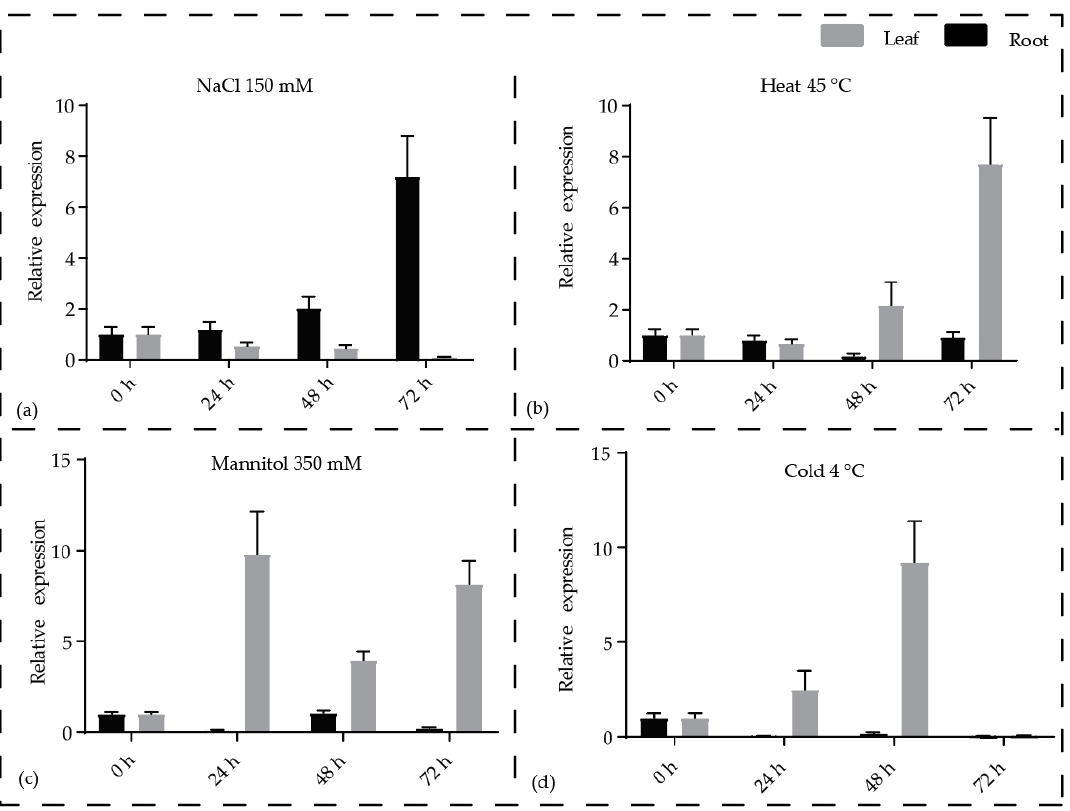
Figure 5. Expression profiles of the pineapple Ac SWC6 subunit in response to di ff erent stress treatments. qRT-PCR of Ac SWC6 subunit at di ff erent time point (0 h, 24 h, 48 h, and 72 h) and samples (leaf and root) after ( a ) Salt (NaCl 150 mM), ( b ) Heat (45 ◦ C) stress ( c ) (Mannitol 350 mM), and ( d ) Cold (4 ◦ C) stress. Data were normalized with pineapple EF1a gene and vertical bars indicate standard error (SE). All experiments were performed with three technical and three biological repeats.